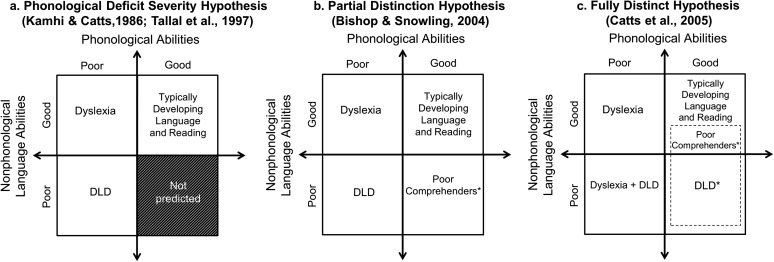
Three hypotheses about the relation between dyslexia and developmental language disorder (DLD) tested by Catts et al. (2005). Panel a depicts the phonological severity deficit hypothesis (Kamhi & Catts, 1986; Tallal, Allard, Miller, & Curtiss,1997), in which both dyslexia and DLD are caused by phonological deficits, with more severe phonological deficits leading to deficits in nonphonological domains. This hypothesis was rejected because of the existence of numerous children who showed deficits in vocabulary, grammar, and discourse, despite good skills in phonology. Panel b depicts the partial distinction hypothesis (Bishop & Snowling, 2004), in which all children with DLD show poor phonology (and therefore poor word reading), but in addition, they also have deficits in the other aspects of language, including vocabulary, grammar, and discourse. This hypothesis was rejected because of the existence of numerous children who met the standard diagnostic criteria for DLD but did not have poor phonology or poor word reading. Panel c depicts the fully distinct hypothesis, in which dyslexia and DLD are fully distinct disorders, with different underlying deficits. This model was supported by data from a large sample of children drawn from an epidemiologic study investigating the prevalence of DLD (Catts et al., 2005) and has been supported in numerous follow-up studies (e.g., Adlof et al., 2017; Bishop et al., 2009; Fraser et al., 2010; Ramus et al., 2013). Children who are referred to in studies as “poor comprehenders” display poor reading comprehension despite adequate word reading abilities. Studies indicate that approximately one third of poor comprehenders met the standard diagnostic criteria for DLD (Adlof & Catts, 2015; Catts et al., 2006; Nation et al., 2004). The remaining two thirds exhibited moderate deficits in vocabulary, syntax, and discourse, although they did not qualify as having DLD.